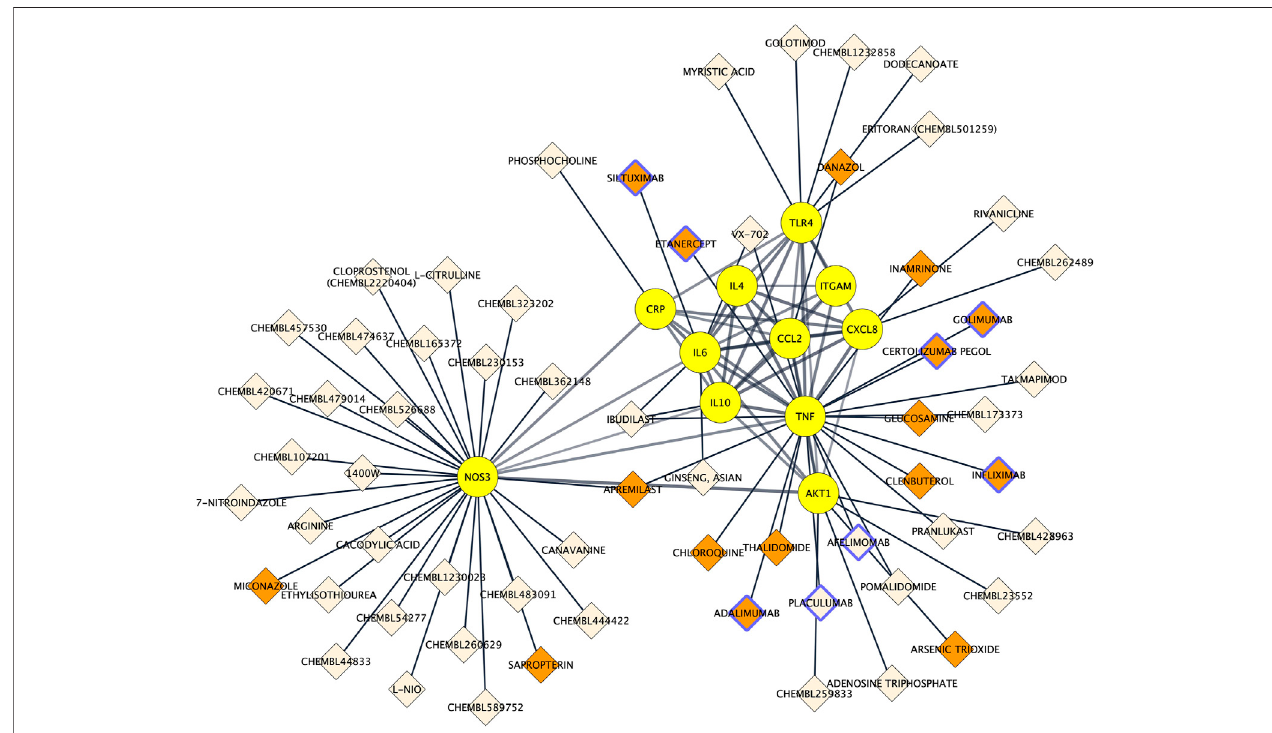
FIGURE 6 | Protein-drug interaction network. Existing associations between drugs (e.g. small molecule compounds or immunotherapies; diamond shapes) and key proteins in Alzheimer ’ s disease neuroin fl ammation (yellow round shapes). FDA-approved drugs and non-FDA-approved drugs are respectively colored in orange and light beige. Protein-based therapies are bordered with